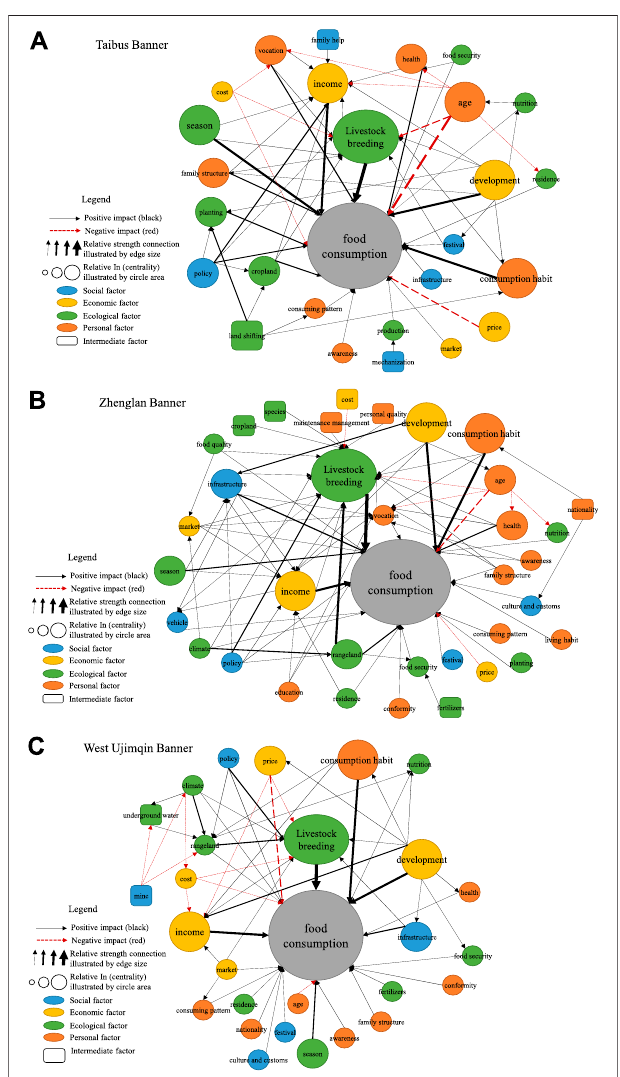
FIGURE 5 | Network of food consumption impact factors in the three typical study areas. (A) network offood consumption impact factors in Taibus Banner; (B) network of food consumption impact factors in Zhenglan Banner; (C) networkoffoodconsumptionimpactfactorsinWestUjimqinBanner. Data source: Results from our 2019 fi eld survey and developed from our previous study (Yang and Zhen, 2020).